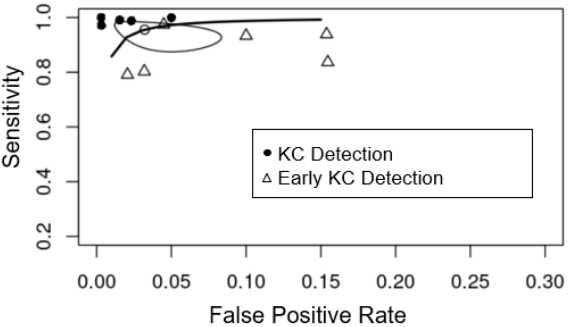
Figure 4. Summary receiver-operating characteristic curves of the diagnostic performance of machine learning detecting KC (black circle) and early KC (triangle) from controls using Pentacam parameters. The white circle is the summary estimate point (sensitivity (0.956 (95% CI 0.897–0.982), specificity (0.968 (95% CI 0.931–0.985)) of studies using Pentacam parameters. The Y-axis represents sensitivity,